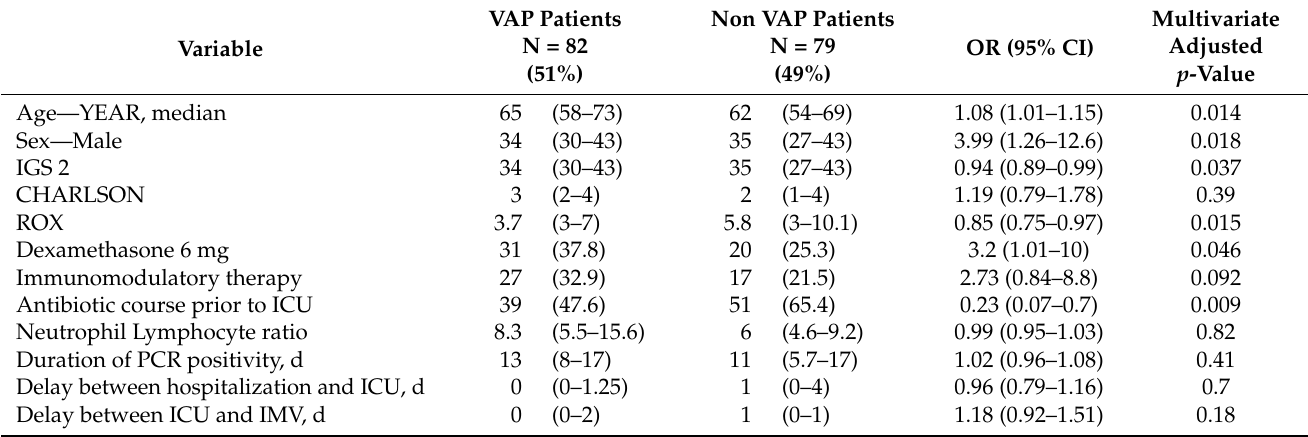
Table 5. Multivariate risk factors associated with